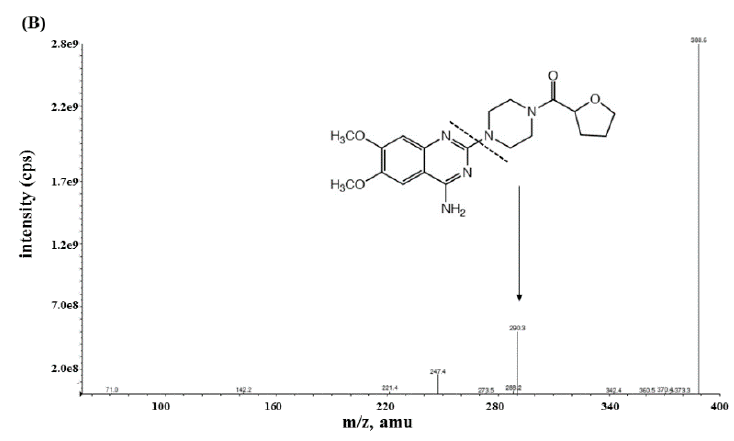
Figure 1. MS / MS spectra of ( A ) sumatriptan and ( B ) terazosin ( IS ). Figure 1. MS/MS spectra of ( A ) sumatriptan and ( B ) terazosin ( IS ). Figure 1. MS/MS spectra of ( A ) sumatriptan and ( B ) terazosin ( IS ).